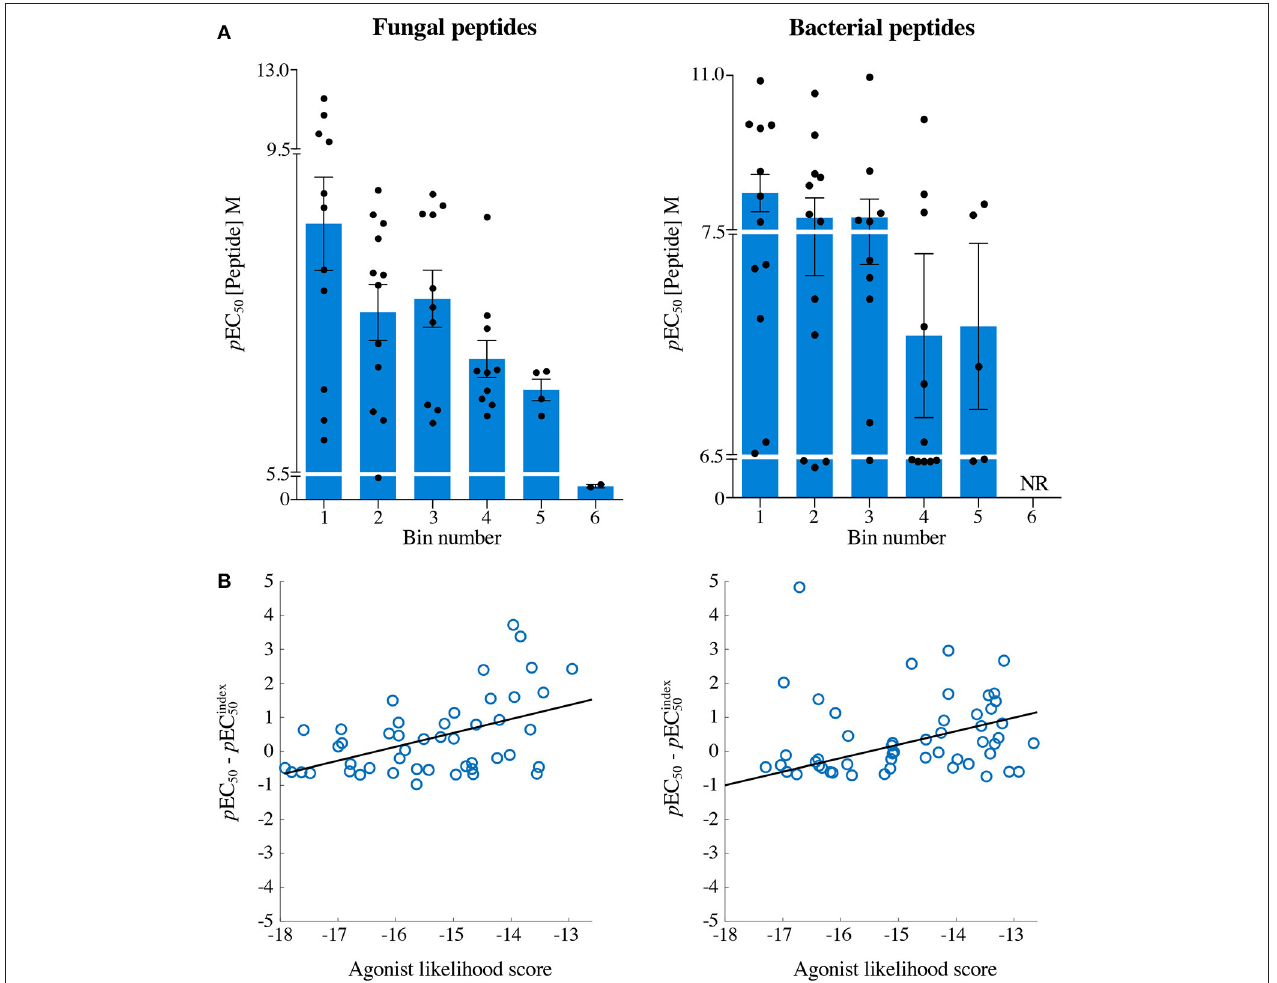
FIGURE 7 | The agonist likelihood score is able to identify fungal and bacterial peptide agonists. (A) p EC 50 values of InsB4 clone activation towards randomly sampled peptides shown in Figures 5 , 6 . NR, no T-cell response. Solid bars depict the mean and error bars the SEM. (B) Scatter plot of relative functional sensitivity ( 1 p EC 50 ) for the 72 fungal and 72 bacterial randomly sampled peptides shown in Figures 5 , 6 vs. agonist likelihood score.